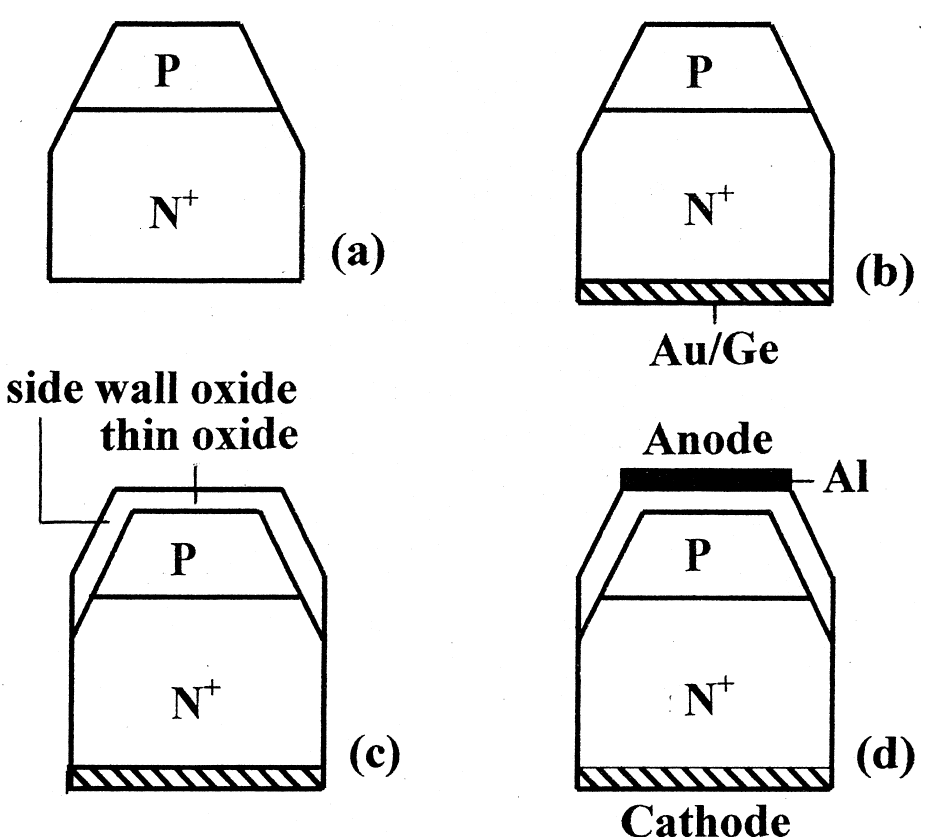
FIGURE 1 The process flow diagrams of the GaAs MISS by LPECO technique (a) mesa etching; (b) cathode ohmic contact; (c) low temperature oxidation; (d) anode schottky